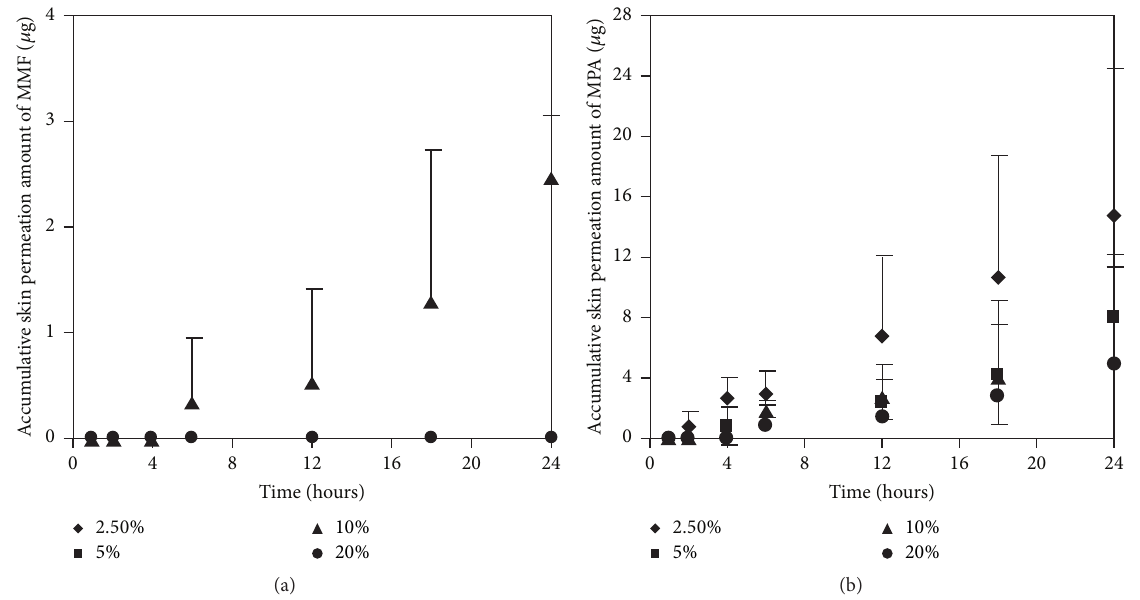
Figure 6: Skin permeation profiles of MMF (a) and MPA (b) at various concentrations of NMP (2.5, 5, 10, and 20 w/v) incorporated to 300 𝜇 g/mL of MMF